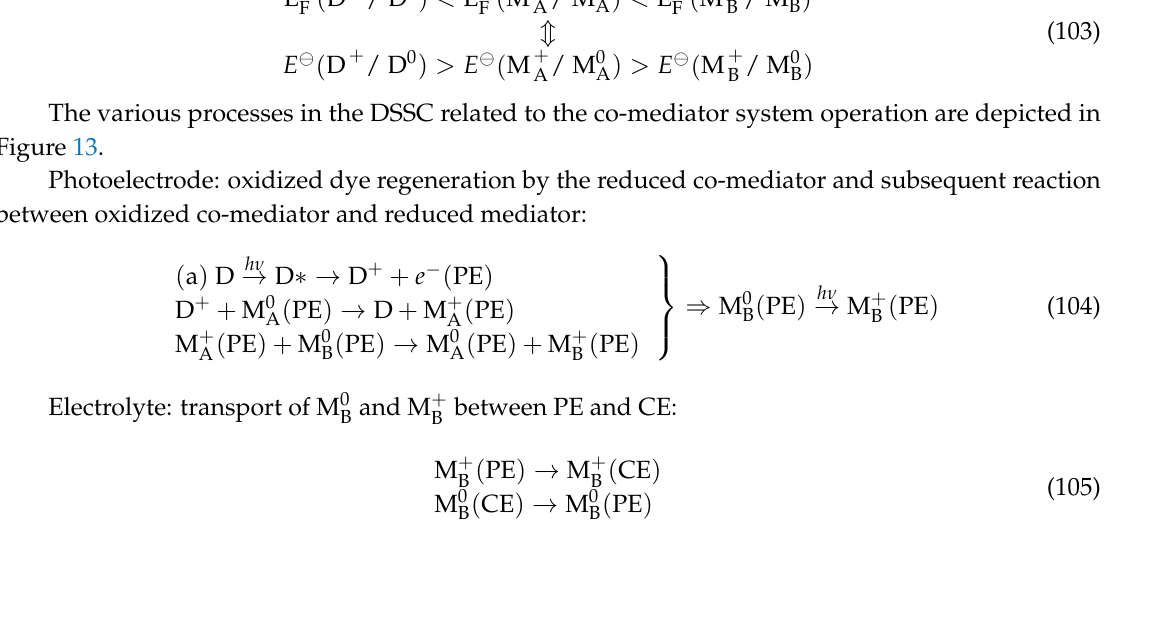
Figure 12. Structures of ( a ) [VO(salen)] +/0 and ( b ) [VO(hybeb)] − 1/ − 2 .